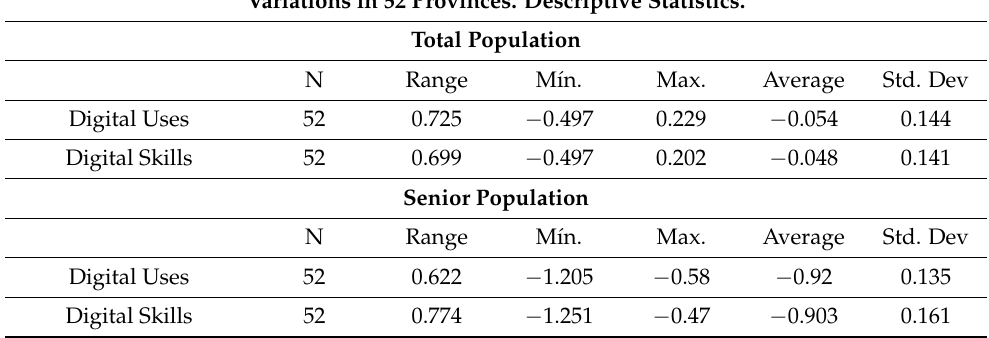
Table 9. Variations in 52 provinces. Variations in 52 Provinces. Descriptive